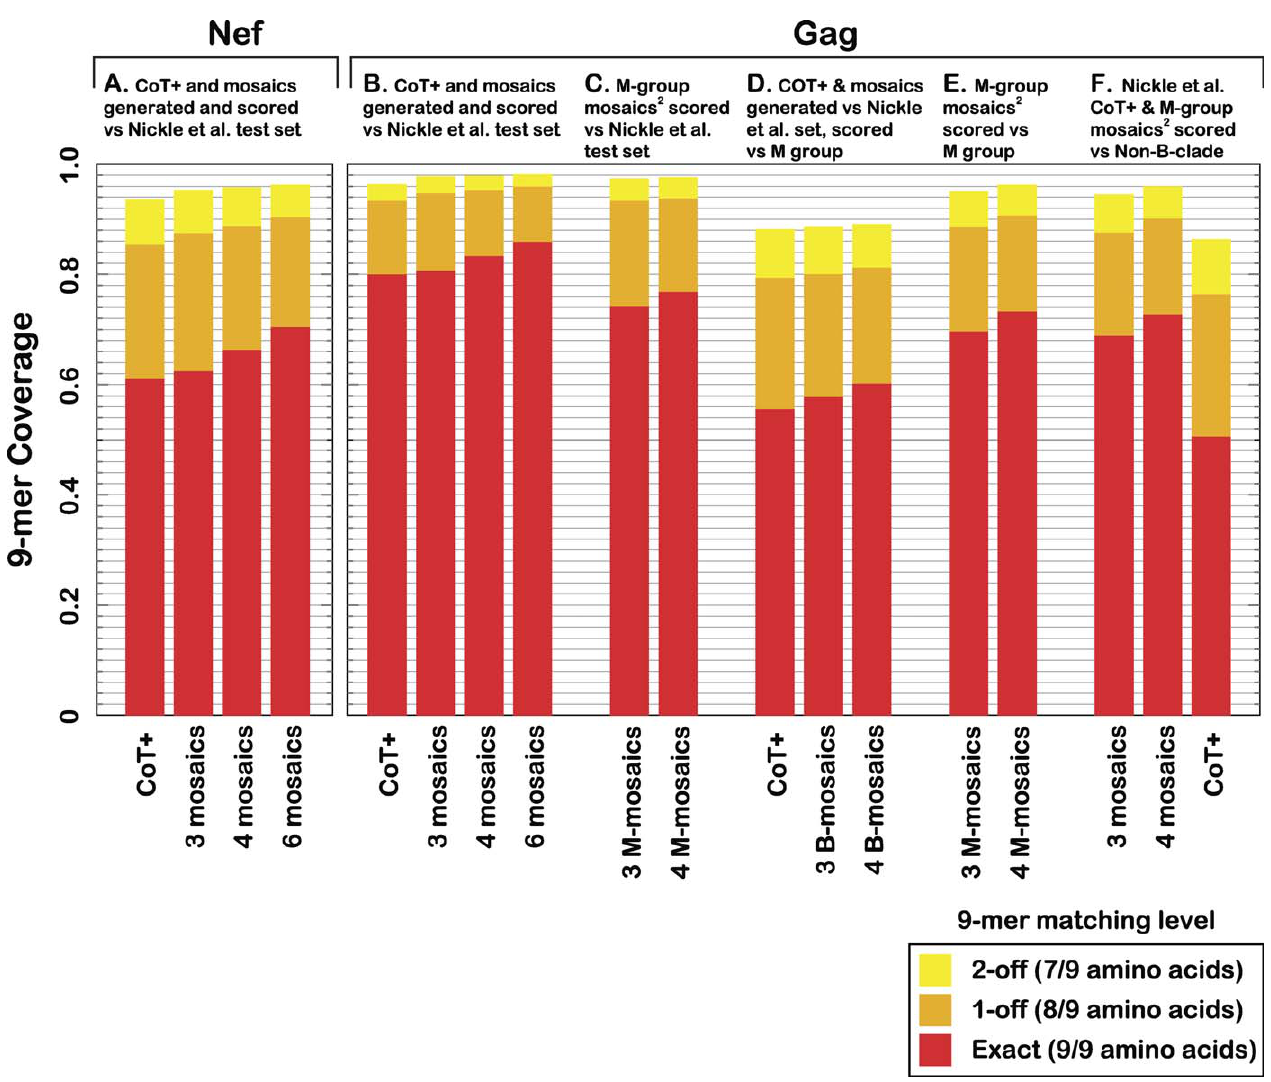
Figure 2. Comparisons of 9-mer Coverage for the COT þ and Mosaic Antigen Designs To allow direct methodological comparison, mosaic antigen sets were generated as in Fischer et al. [2], but based on the test set of 169 sequences used in Nickle et al . [1] for Nef (A) and Gag (B,D). Potential epitope coverage provided by the combination of proteins is indicated by the percentage of perfectly matched 9-mers in the protein alignment (red), the addition of those that match in 8/9 amino acids (orange), and the further addition of those that match in 7/9 amino acids (yellow). Three full-length mosaic proteins provide slightly better coverage than three gene lengths of COT þ protein fragments. For this class of methods, coverage may generally be improved by increasing the number of antigens, but with diminishing returns and at the cost of increased vaccine complexity and expense; the best strategy must realistically balance these factors. Previously published mosaic sequences (based on 551 Los Alamos sequences spanning the entire M group [2]) were scored against the 169-sequence Gag set (C), and the M group (E). To directly compare the coverage of each antigen set to subtypes other than B, the COT þ antigen set and the M-group mosaics were also scored against an M-group dataset from which all B-clade sequences had been removed (F). The M-group mosaic coverage of non-B clade proteins is 4%–5% less than the M-group coverage of B clade (C,F). Predictably, interclade coverage of the B-clade–optimized antigens drops dramatically (81% ! 51% for COT þ , F; B-clade mosaics slightly less reduced ([2], unpublished data). For the M-group global mosaics, in contrast, coverage is roughly equal for all clades; coverage of B-clade sequences by M-group mosaics is only 6%–7% below that of specific B-clade–optimized mosaics (B,C), and coverage of non-B sequences remains relatively high (F). All computer code for creating mosaics and assessing coverage, our previously designed mosaic antigens, and the datasets used were made publicly accessible upon the original publication